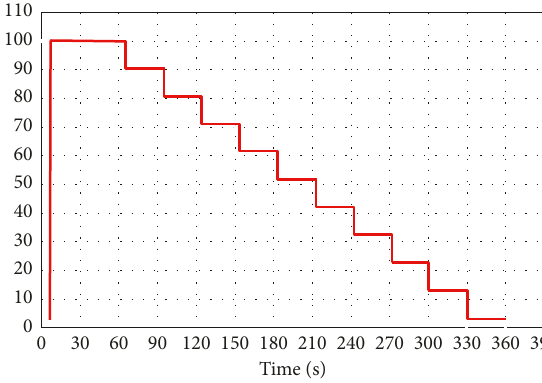
Figure 3: Shear rate mode of rheological